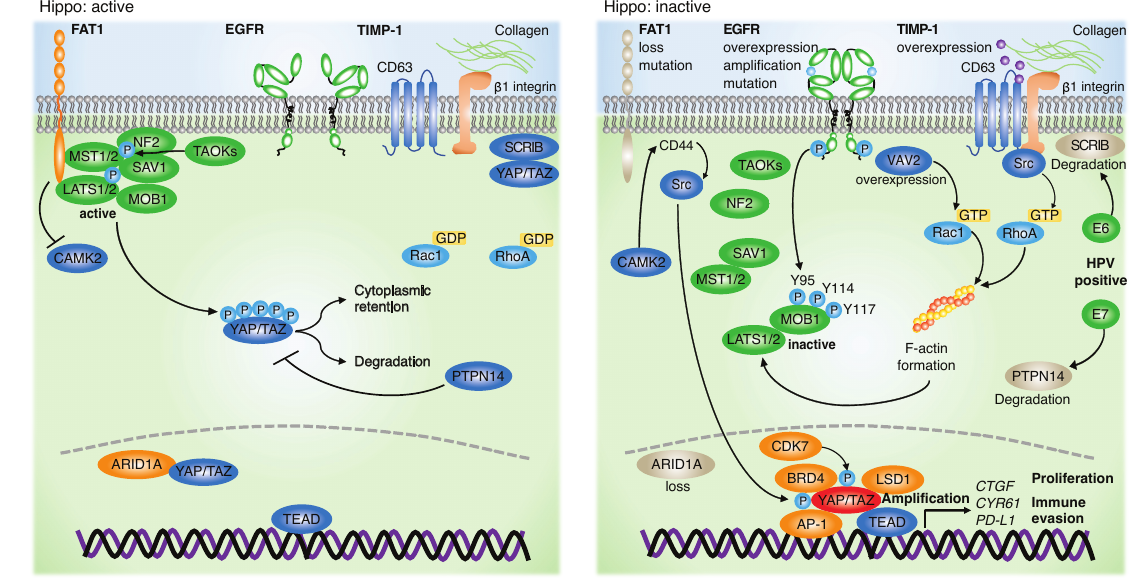
Figure 3. Schematic of the Hippo pathway and YAP/TAZ regulatory components in HNSCC. When the Hippo pathway is active, activated LATS1/2 phosphorylates YAP/TAZ at multiple serine residues, leading to its cytoplasmic retention or degradation. When Hippo is inactive, dephosphorylated YAP/TAZ translocates to the nucleus, binds to TEAD, and enhances transcription of growth-related genes. Genetic alterations including FAT1, EGFR, VAV2, TIMP-1, HPV (E7), ARID1A, BRD4, LSD1, AP-1, CDK7, and YAP1 are involved in aberrant YAP/TAZ activation. Abbreviations are: Rac family small GTPase 1 (RAC1), Ca2+/calmodulin-dependent protein kinase II (CAMK2), and scribble homolog